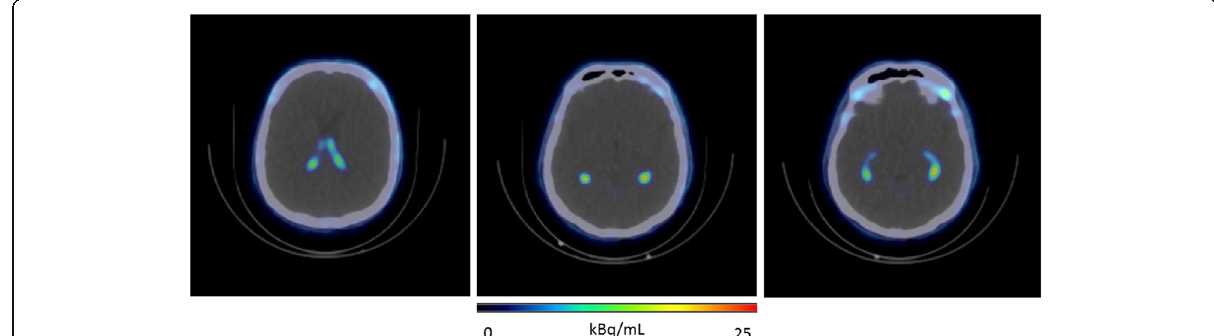
Fig. 2 Typical 18 F-AzaFol uptake pattern in the choroid plexuses (lateral ventricles) for a representative patient at 30 min